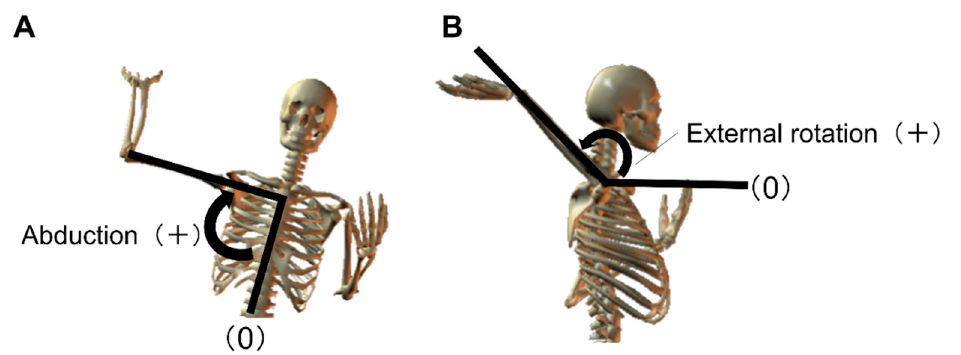
Figure 1. Shoulder joint angle. ( A ): abduction, ( B ): external rotation.